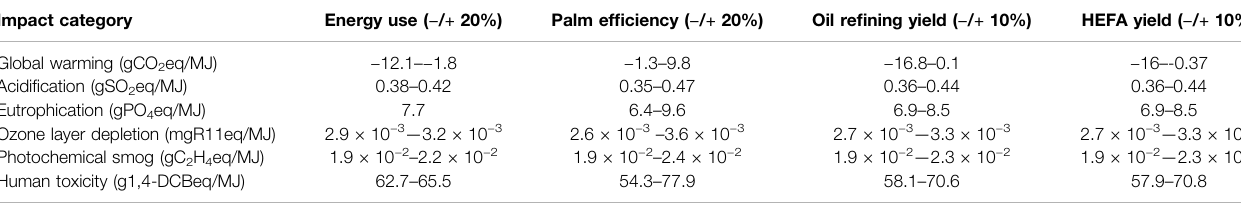
TABLE 5 | Effect of production parameters on emissions. Impact